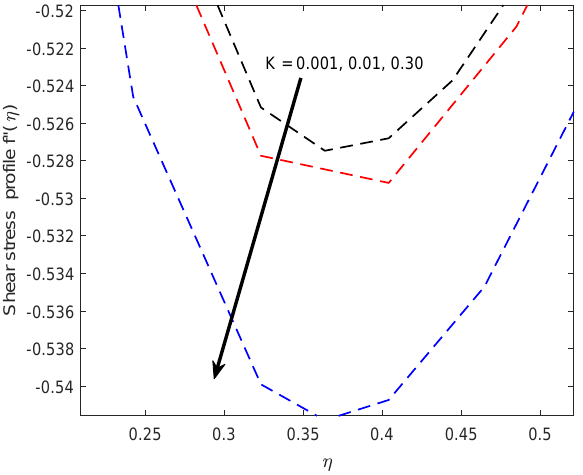
Figure 8: Variation of temperature profile with rotation parameter